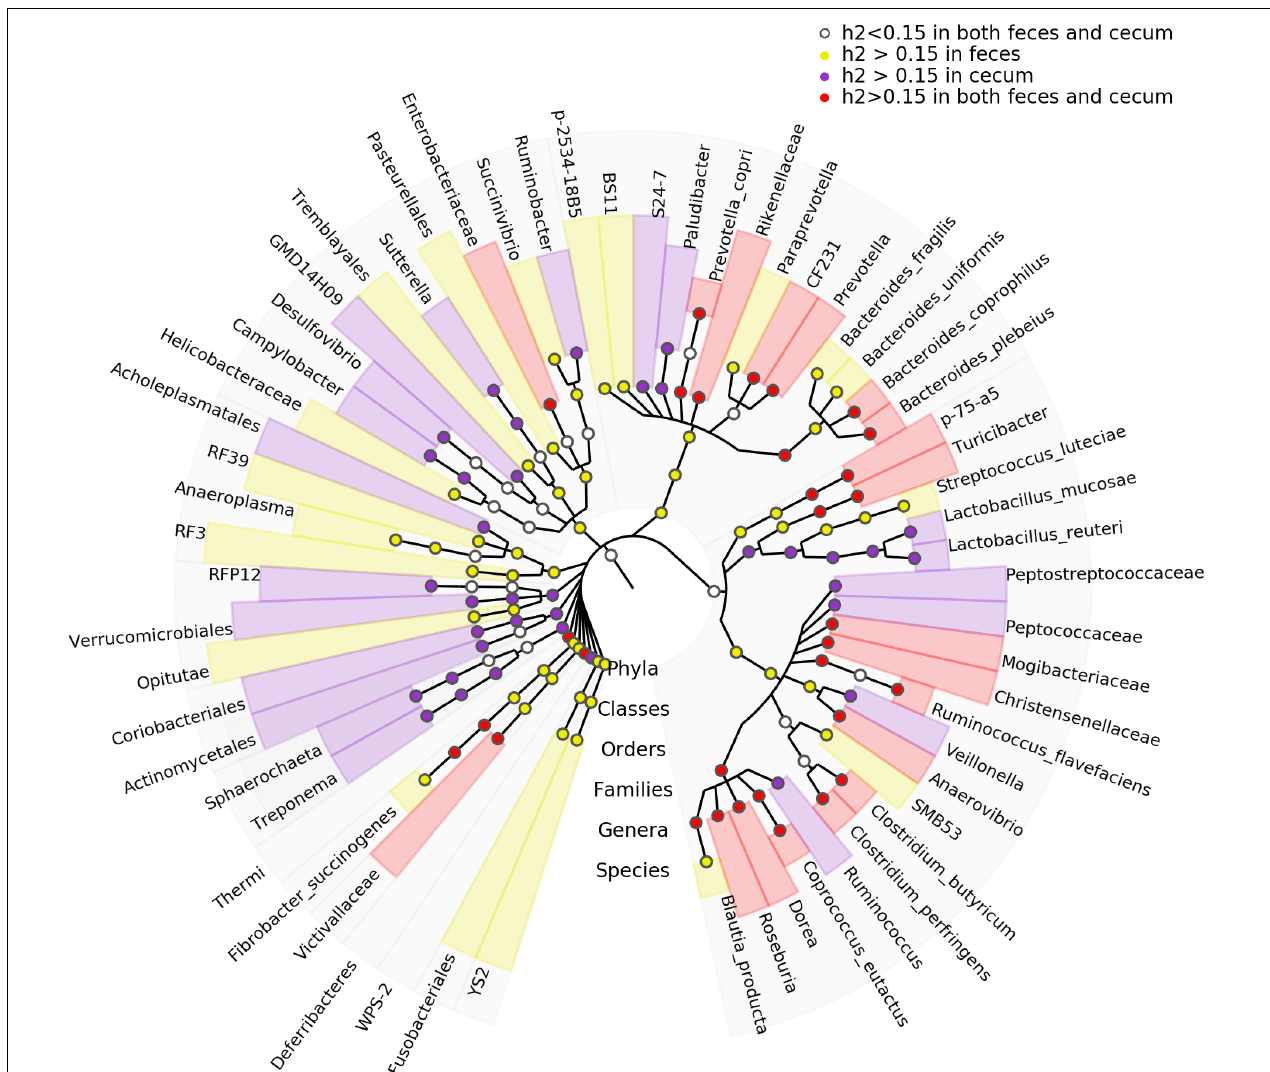
FIGURE 4 | Taxonomic representation of heritable bacteria taxa. The central dot in cladogram represents kingdom; each successive circle moving outward is one step lower phylogenetically. The phylogenic relationships of the taxa were obtained by the RDP database (Release 11.4). The circles showing different colors represent the taxa with different strength of heritability in cecum lumen and feces as measured by h 2